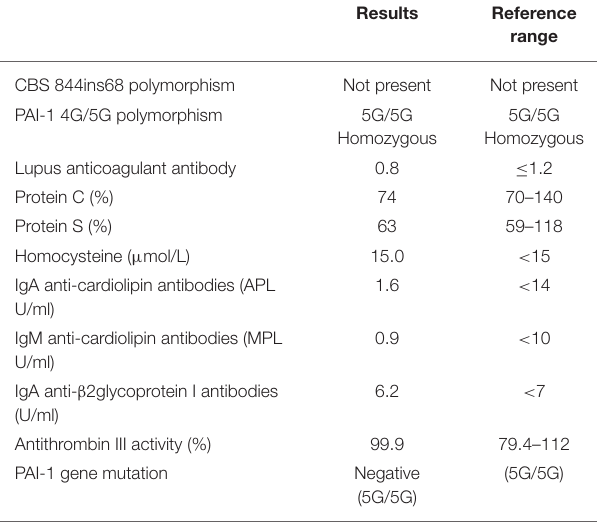
TABLE 1 | Main laboratory tests at the time of delivery and thrombophilia screening 4 months